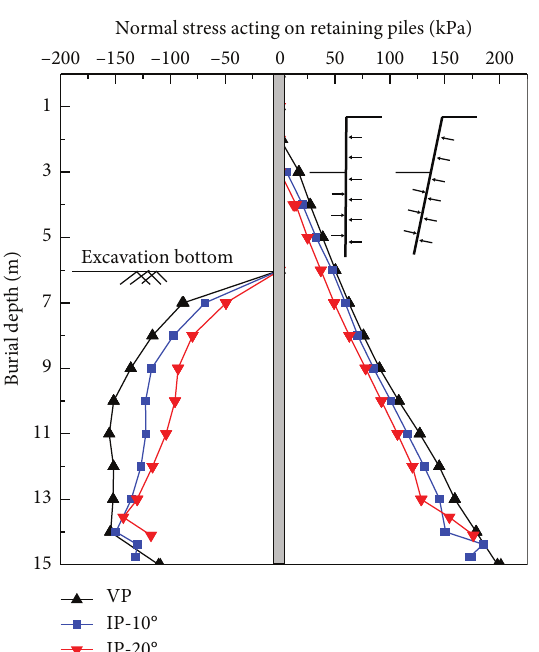
Figure 11: Normal stress acting on VP and IP at an excavation depth of 6m.